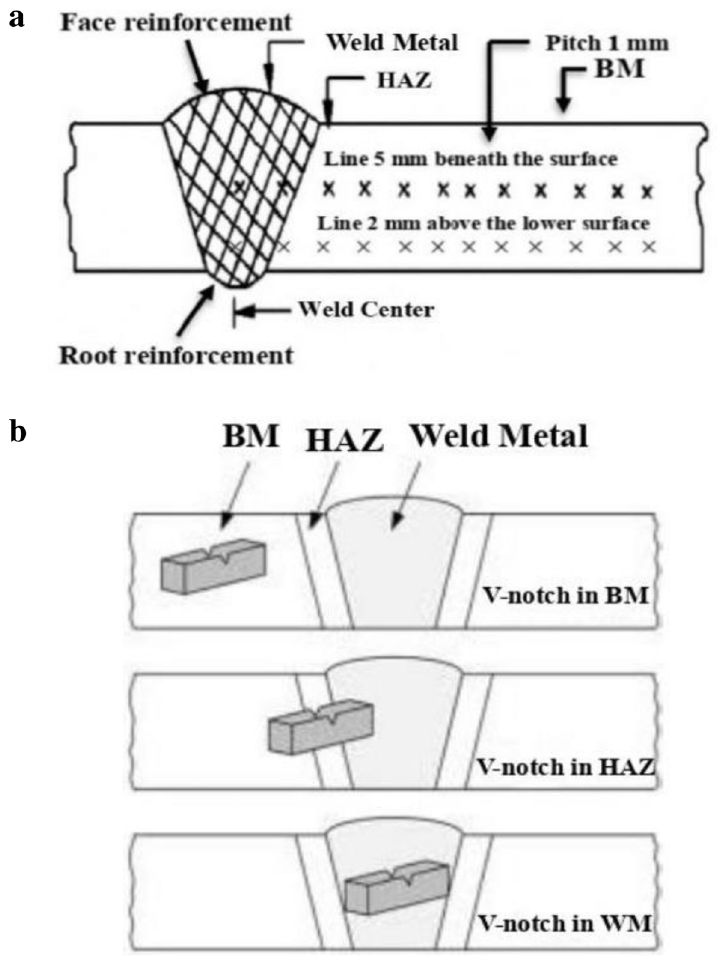
Fig. 4 a Location of hardness distribution measurements of the welded specimen [16]. b Location of V-notch of the welded specimen for impact test [36]